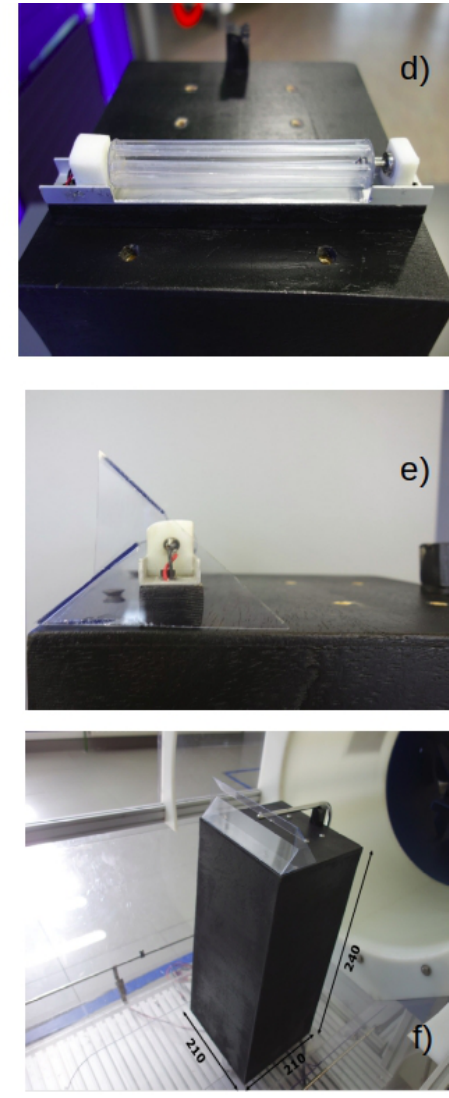
Figure 3. Design and dimensions of the small Savonius model and the PAGVs (Power Augmenting Guiding Vanes) ( a )–( c ) and the corresponding photos of the small-scale building with the real Savonius and the PAVs ( d )–( f